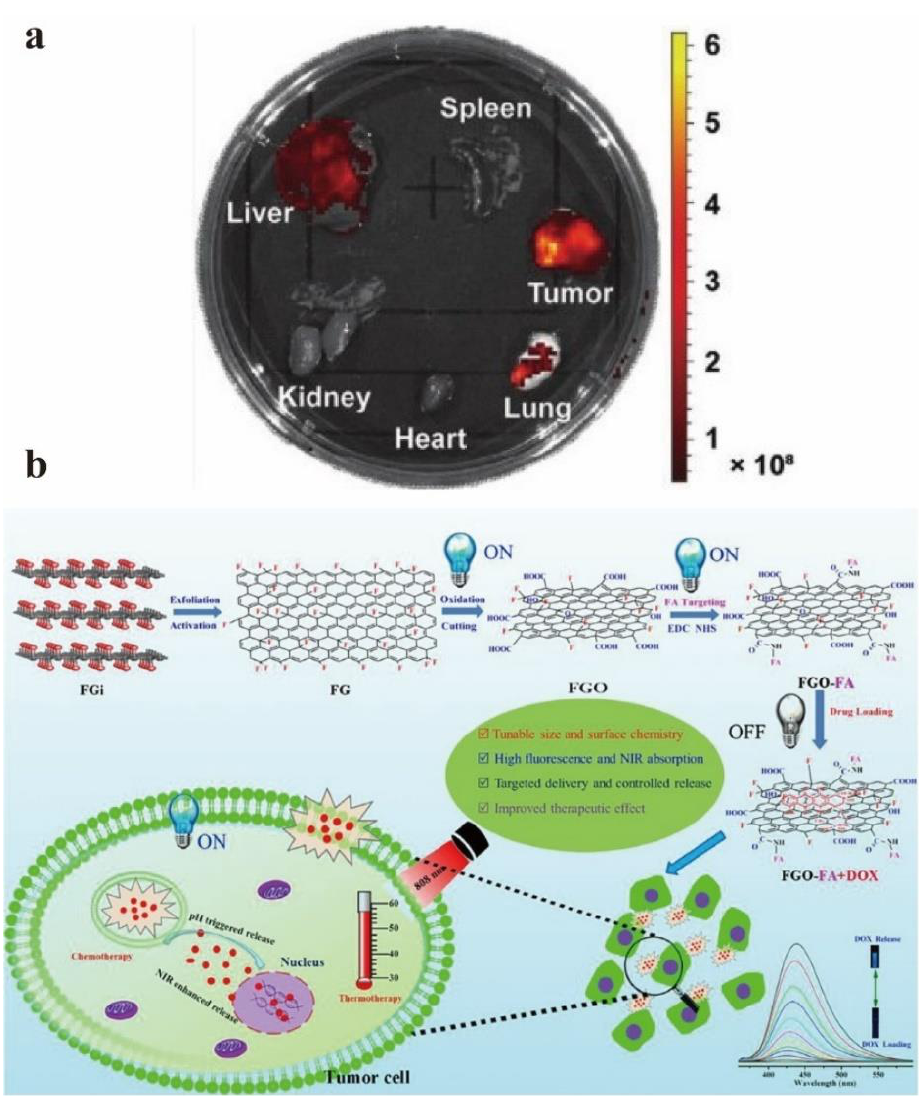
Figure 17. ( a ) Organ imaging 24 h after injection of GO – DNA nanomaterials. Reprinted with permission from [102]. Copyright 2021, John Wiley and Sons. ( b ) The schematic diagram of the targeted GO drug delivery system was prepared by controlling the structure and surface chem- istry, convertible fluorescence and collaborative treatment. Reprinted with permission from [103]. Copyright 2018,